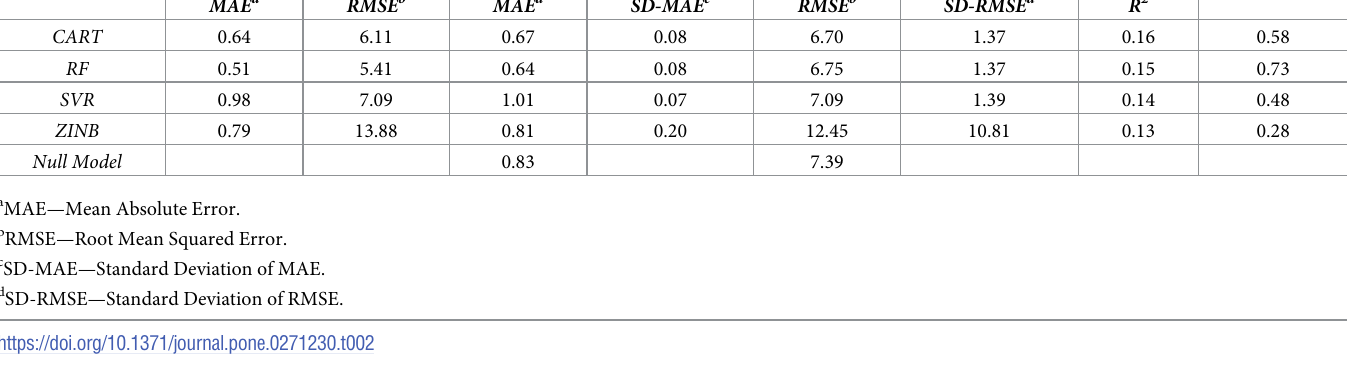
0.73 and ρ = 0.86). 99.2% of flood events predicted by the classifier (i.e., the observations GFF shown in these figures) are captured within the red boxes; S10c and S10d Fig plot the fitted and the observed values in these red boxes for the FPR and the GFF models respectively.